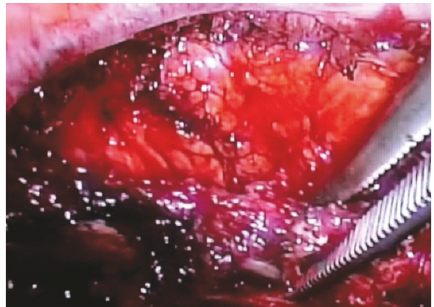
Figure 2: A Roberts clamp is used to retract the first rib.